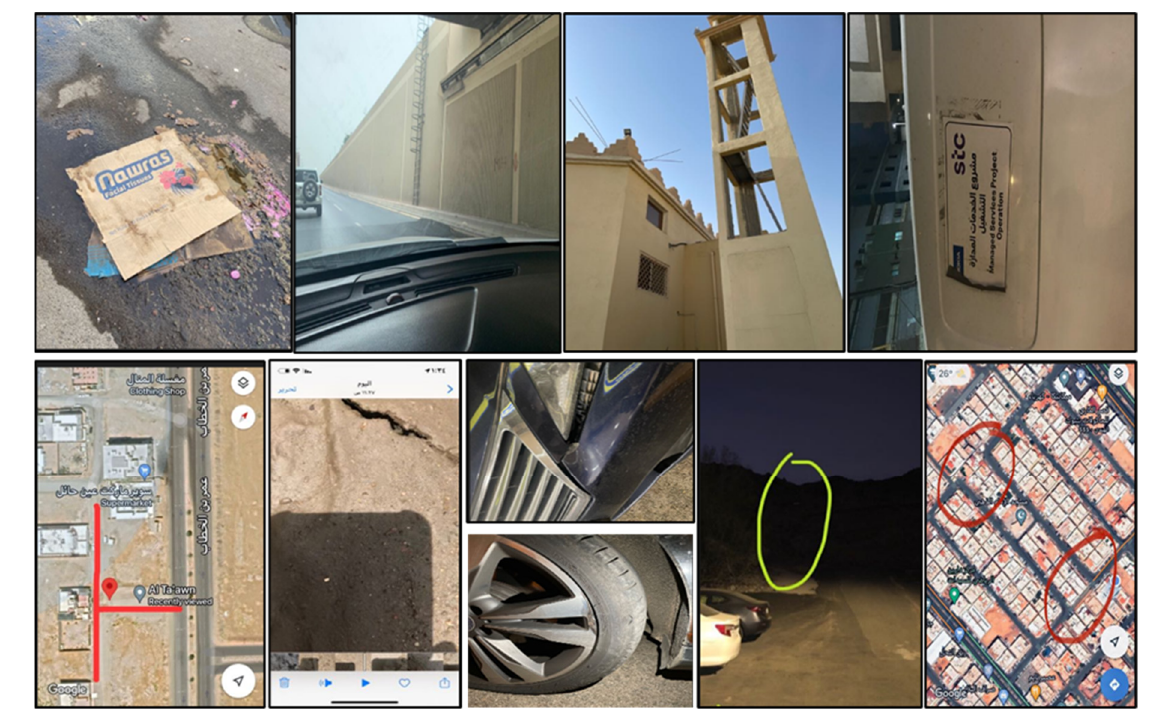
Figure 5. Some examples of the irrelevant images that are excluded during the pre-processing step.